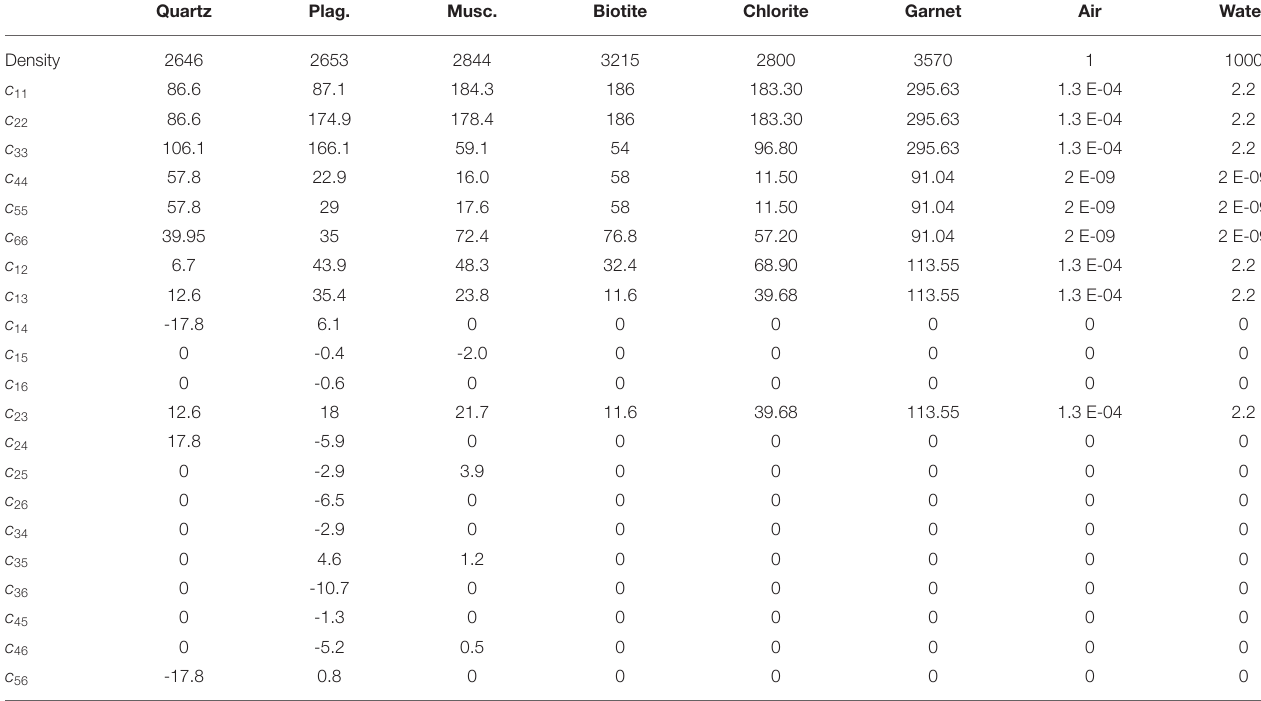
TABLE 1 | Elasticity (in GPa) and density (in kg/ m 3 ) of mineral phases present in our samples. Quartz Plag. Musc. Biotite Chlorite Garnet Air Water Density